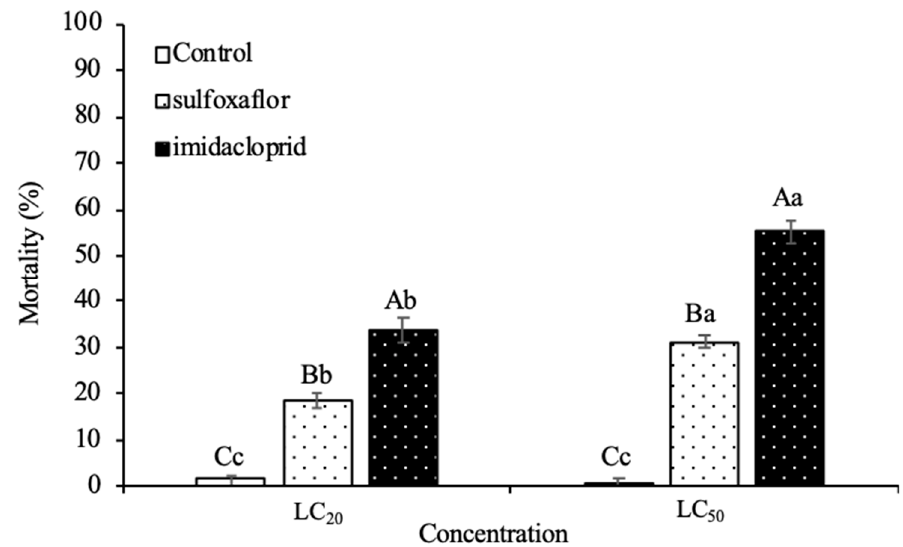
Figure 1. Mean ( ± SE) of percentage mortality of Harmonia axyridis females exposed to imidacloprid and sulfoxaflor and their LC 50 and LC 20 estimated for the target pest, Aphis gossypii . Columns bearing the different letter (capital letters: within the same concentration regime; lowercase letters: within the same tested insecticide) are significantly different (Tukey’s HSD test for multiple comparisons at p < 0.05).